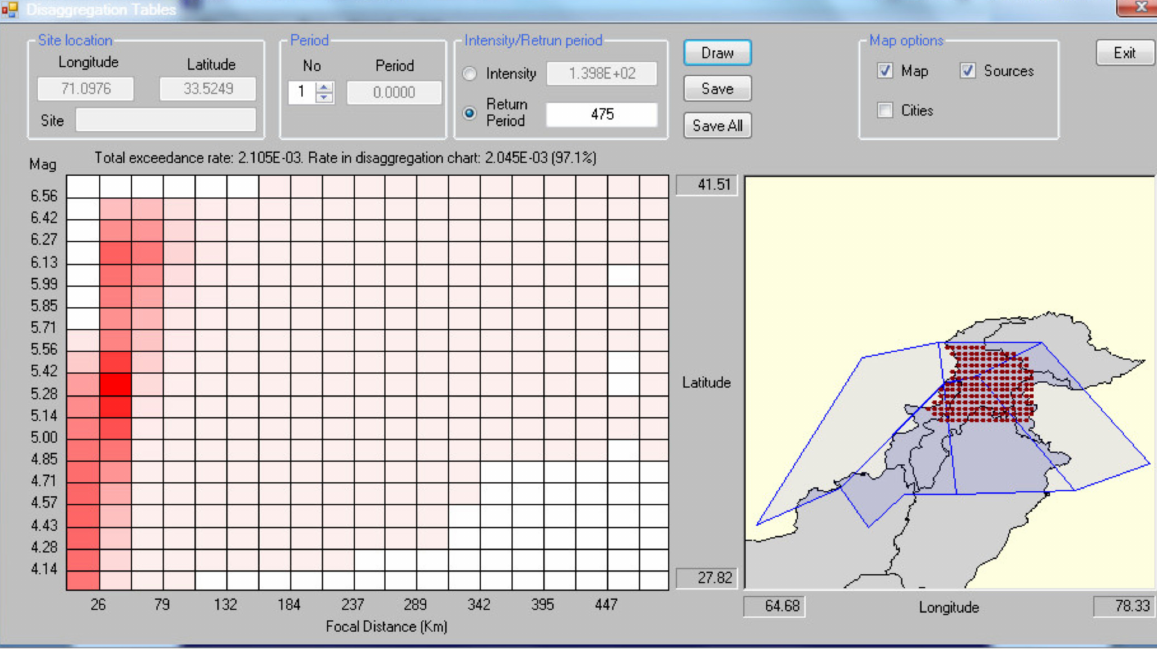
Figure 14. De-aggregation results for CB08 attenuation